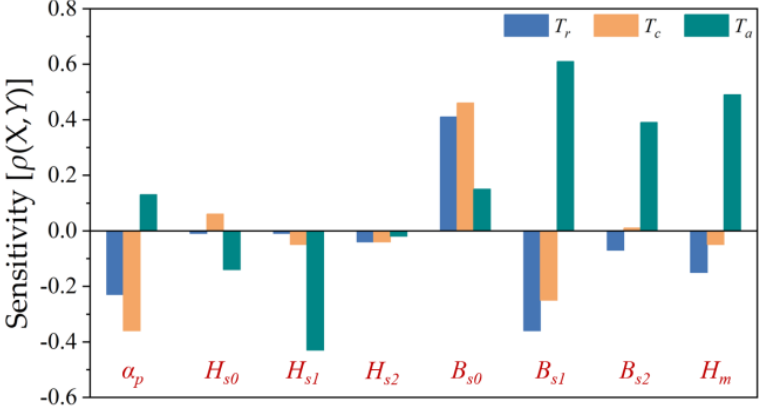
Figure 3. Analysis of sensitivity of structural parameters to three optimized objectives. Figure 3 depicts the direction and magnitude of the association between each struc- tural parameter and the optimization aim. B s 0 correlated positively with the cogging torque, torque ripple and average torque. If B s 0 changed in a way that promoted an increase in the average torque, the cogging torque and torque ripple likewise rose. This suggested that three optimized objectives did not always alter in a positive direction when B s 0 was modi- fied. Consequently, it was essential to implement the approach of trade-off